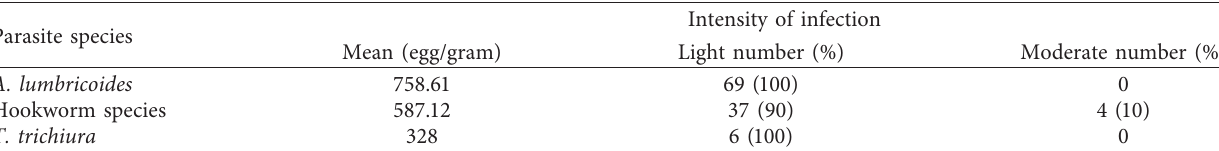
Table 3: Intensity of STHs among adolescents and adults ( n � 641) in Bibugn Woreda, East Gojjam, Ethiopia, from February to September